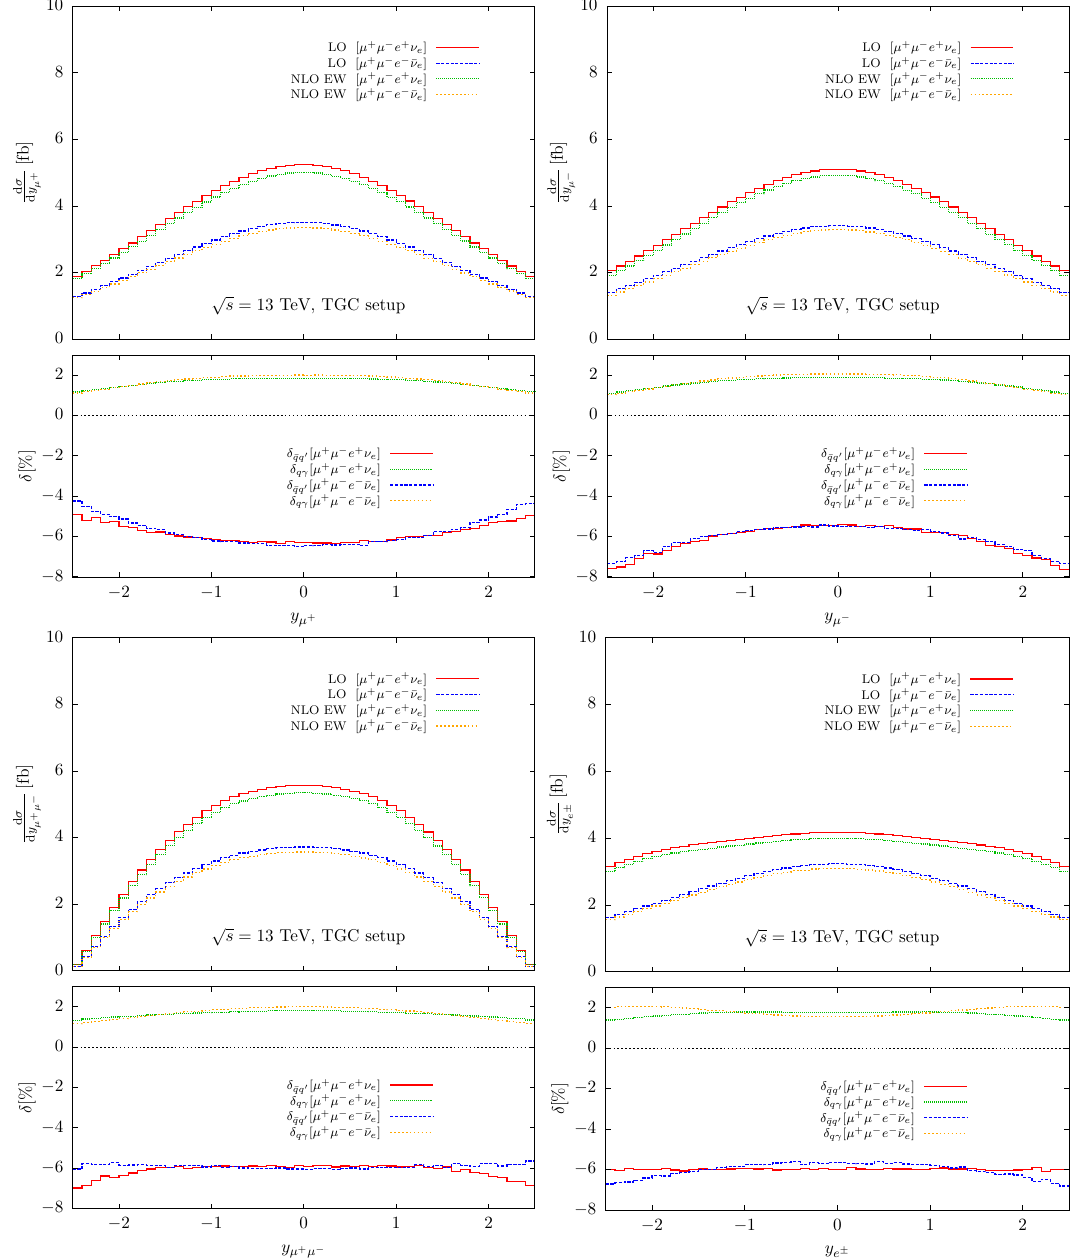
Figure 8 . Distributions in the rapidities of the W and Z decay leptons in the TGC setup for ZW + and ZW − : µ + (upper left panel), µ − (upper right panel), µ + µ − pair (lower left panel) and e ± (lower right